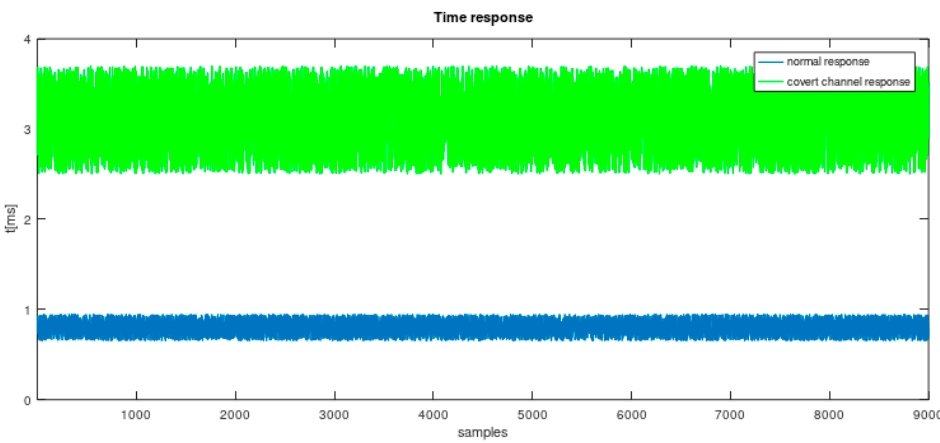
Figure 12. Time response for classic structure and structure extended around the proxy (9000 samples taken from a two-minute trend.